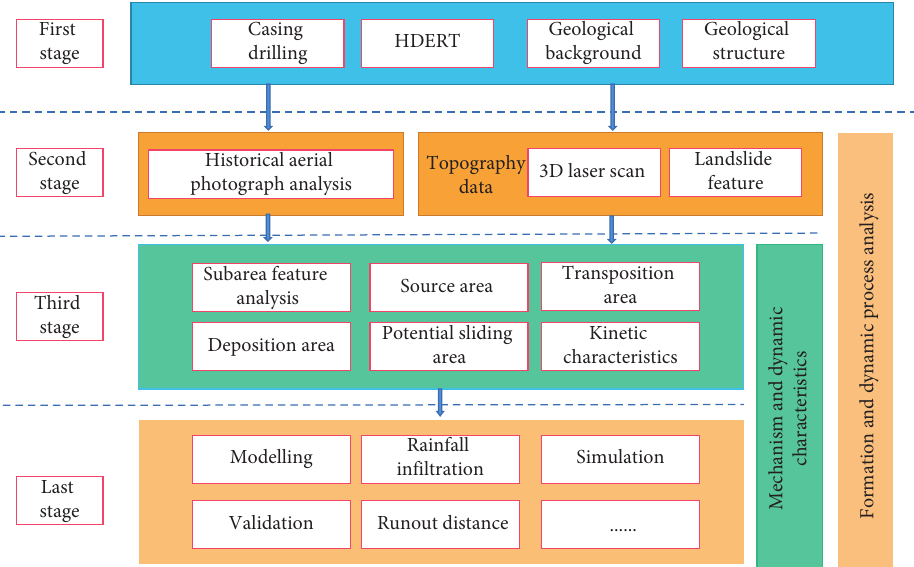
Figure 5: Methodology for the formation and dynamic process analysis.